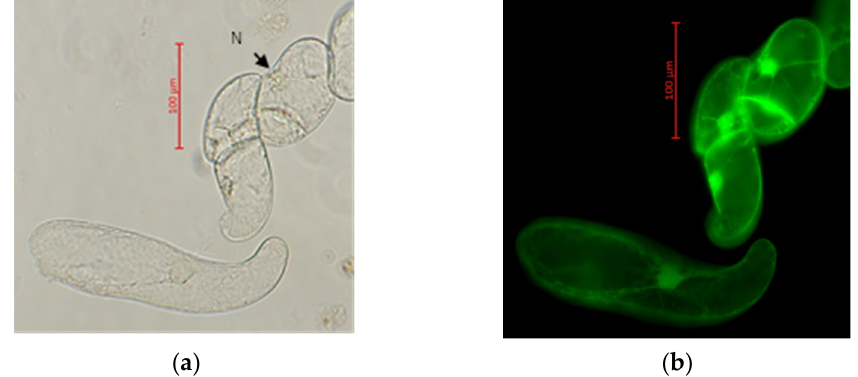
Figure 1. Microscopic images of Rhus coriaria cells taken using AXIO-Imager A2 optical microscope (ZEISS) at a magnification of 20 × . ( a ) In the brightfield mode; N, nucleus. ( b ) Cells after staining with fluorescein diacetate. Scale bar: 100 µm.